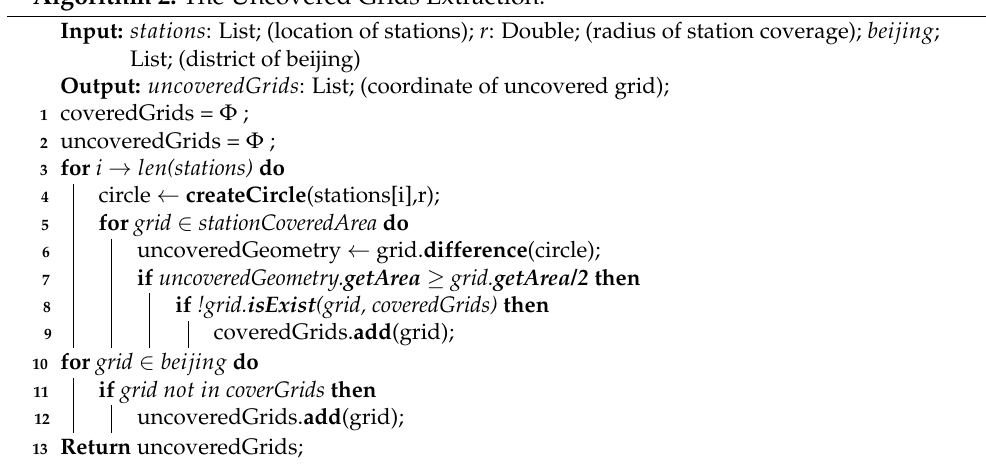
Algorithm 2: The Uncovered Grids